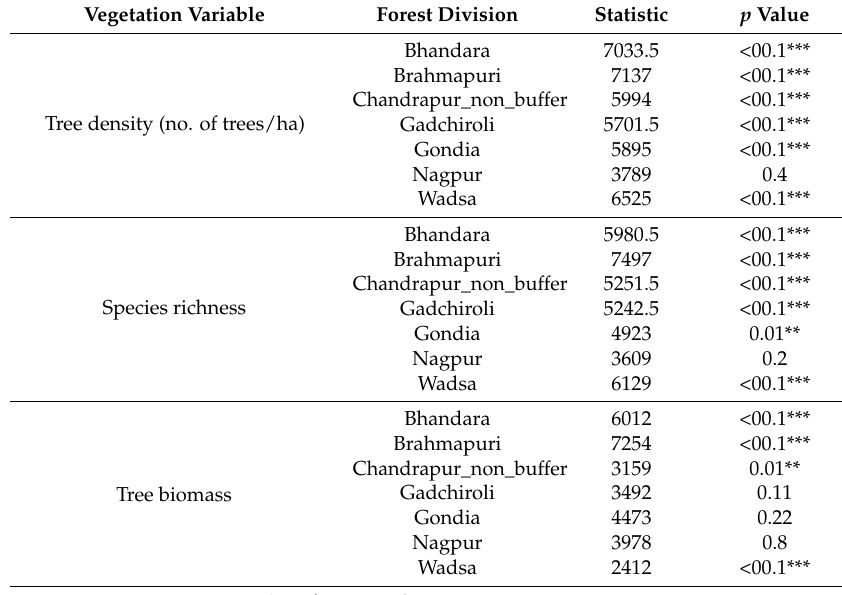
Table A1. Comparison between villages with forest division based on Mann–Whitney U test. Vegetation